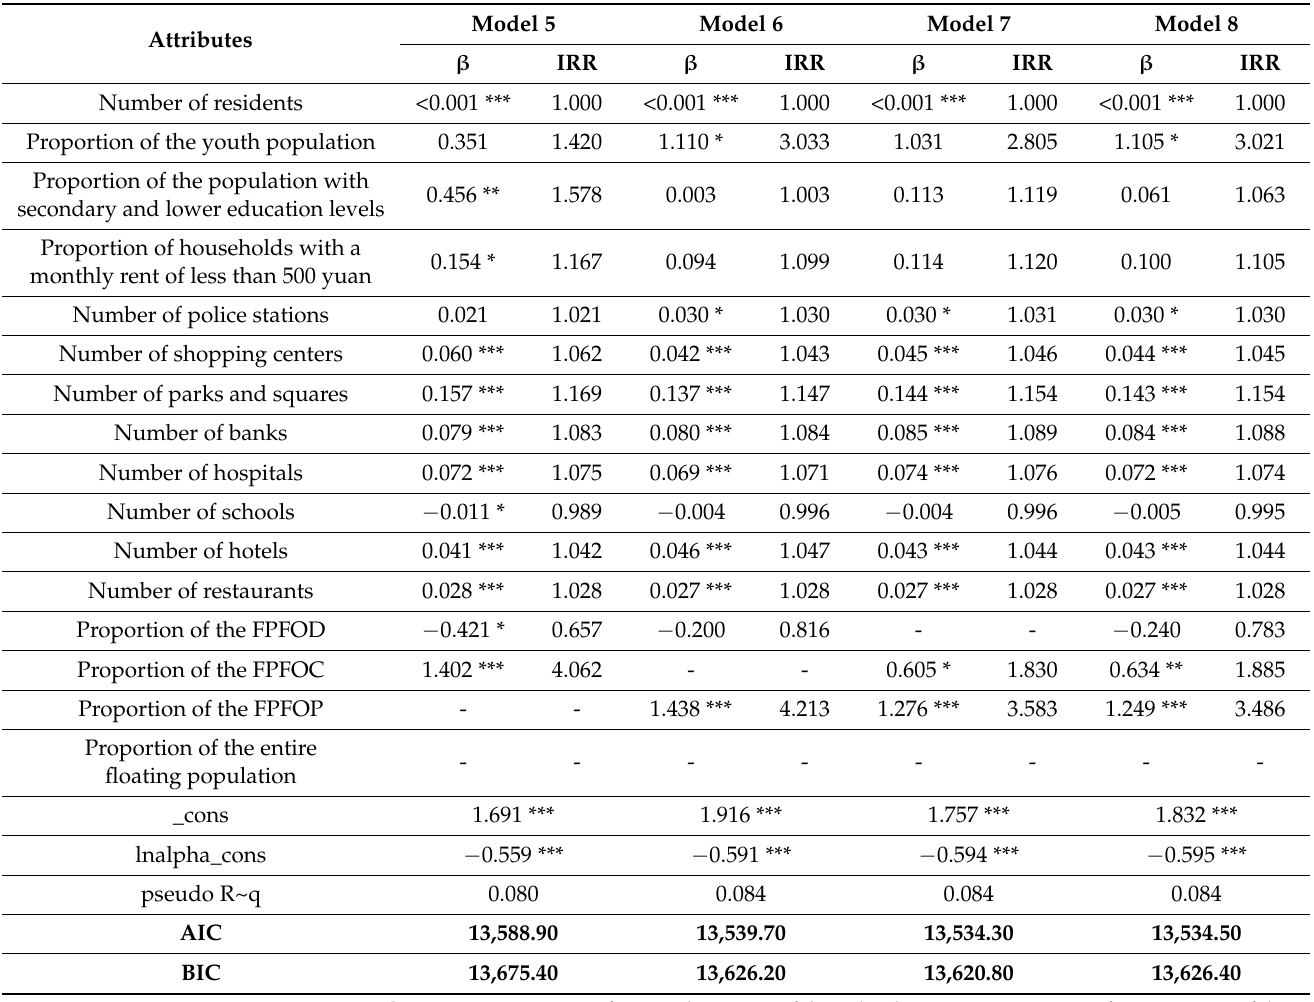
Table 3. Results of Model